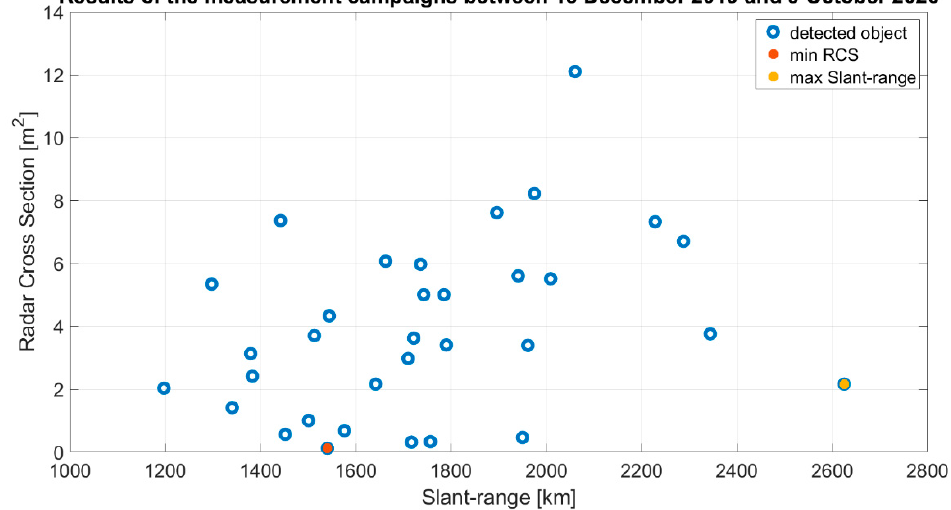
Figure 10. Spectrogram of the passage for the object ID 37387, detected by the BIRALET radar on 13 December 2019.